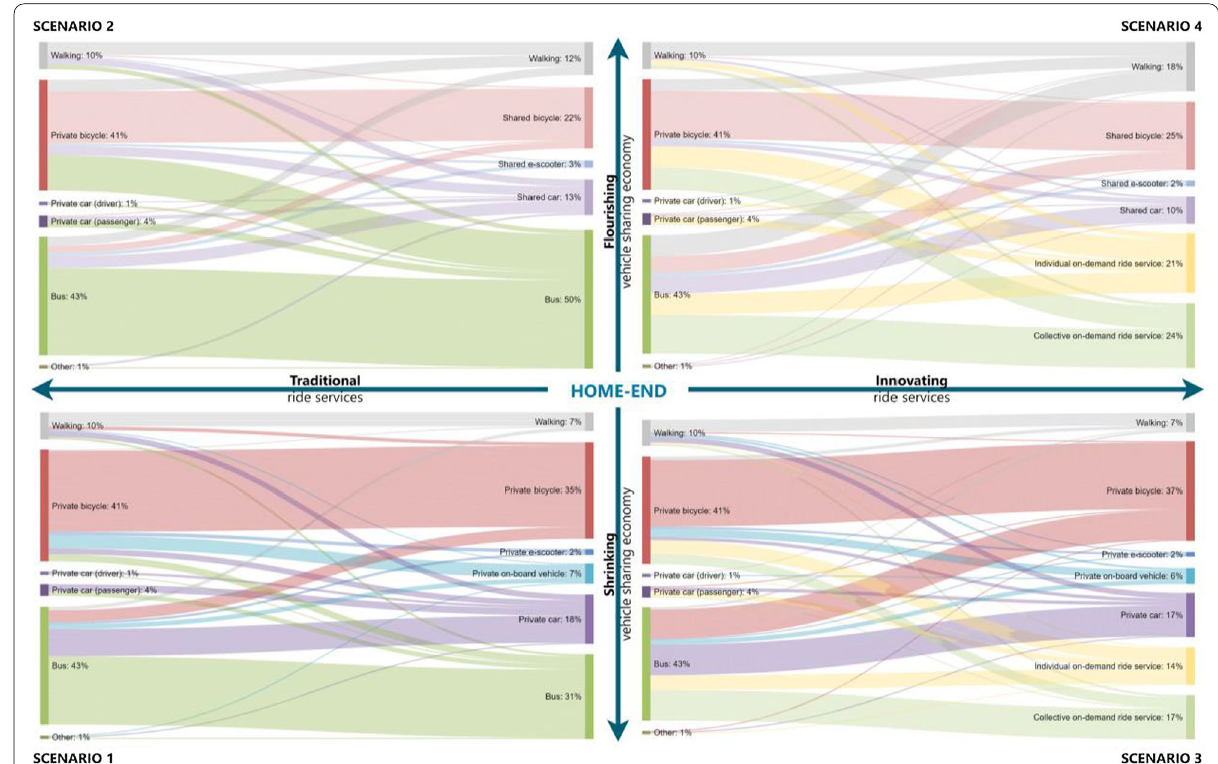
Fig. 5 Expected modal shift for home‑end trips in all four